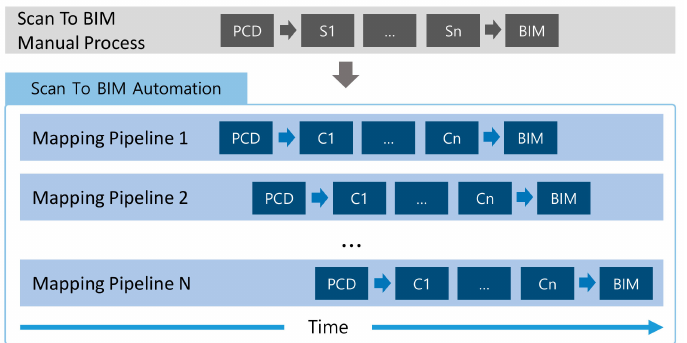
Figure 1. Scan-to-BIM Mapping Pipeline Concept